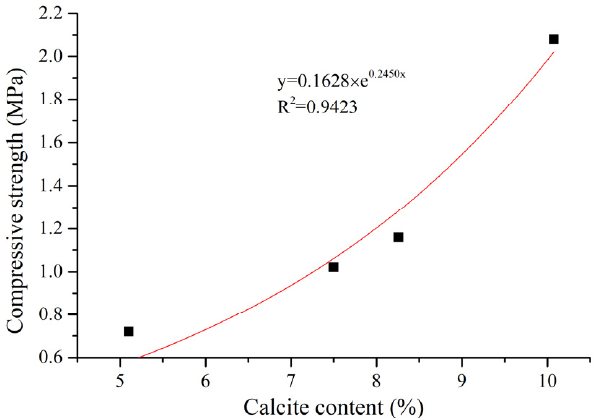
Figure 4. Relationship between calcium carbonate content and the compressive strength of sand columns.